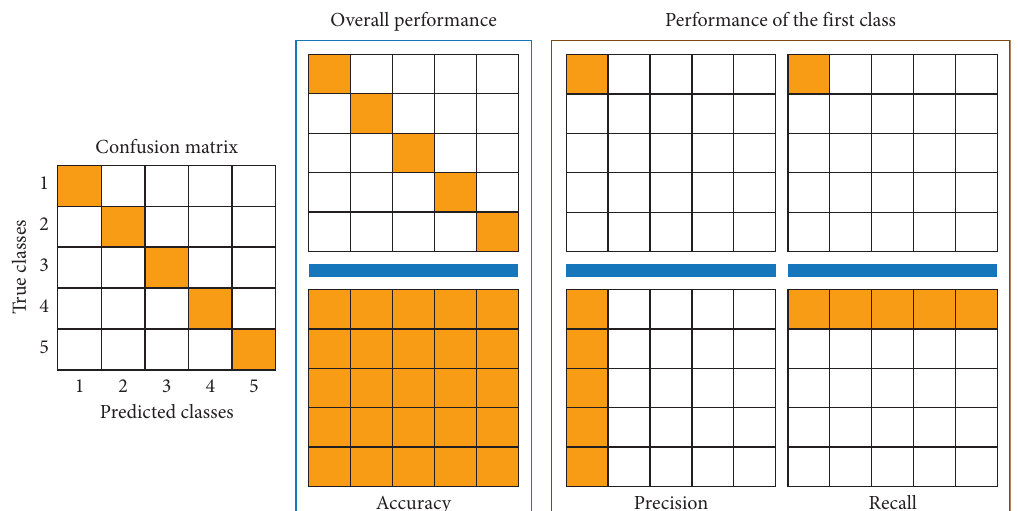
Figure 12: Examples of the procedure used for calculating the accuracy and